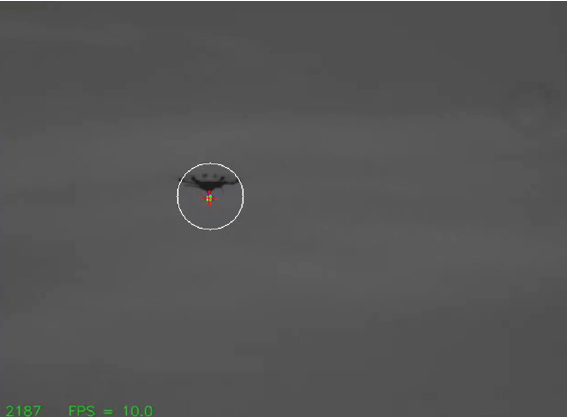
Figure 4. Image from the machine vision tracking camera. The red cross shows the detected position of the beacon LEDs. The white circle shows the tip/tilt mirror actuation range, centred on the predetermined